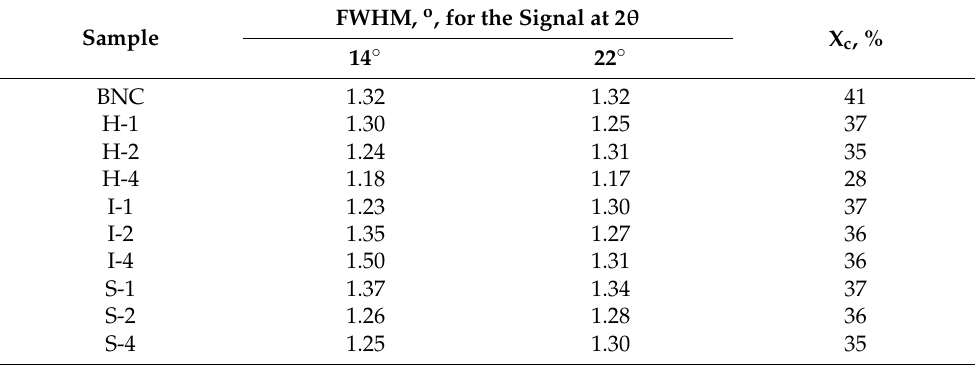
Figure 4. XRD patterns of BNC/PVA composites obtained by the in-situ ( a ), ex-situ/impregnation ( b ), and ex-situ /sterilization ( c ) methods. Table 3. The full width at a half maximum (FWHM, ◦ ) and the degree of crystallinity (X c , %) of BNC and BNC/PVA composites from XRD